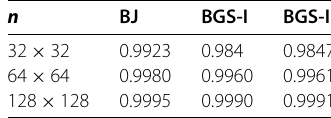
Table 1 Radii of the classical iterative